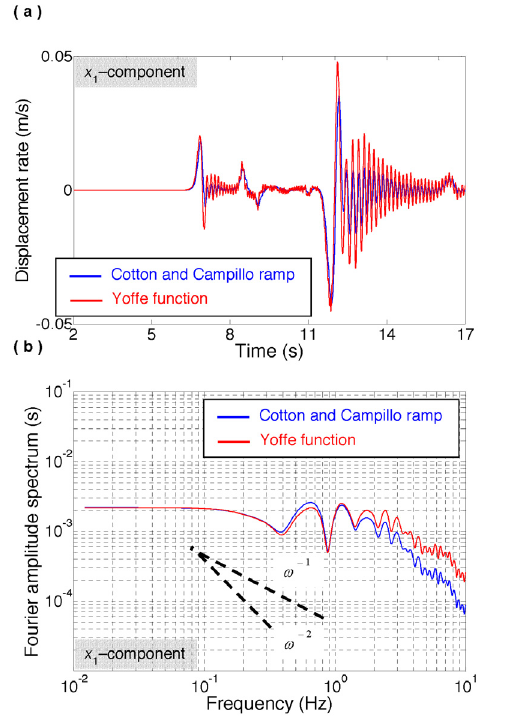
Figure 9. (a) The same as Figure 3a, but now for a free surface re- ceiver located at a distance of 40 km from the epicenter and 5 km from the fault trace. (b) Corresponding